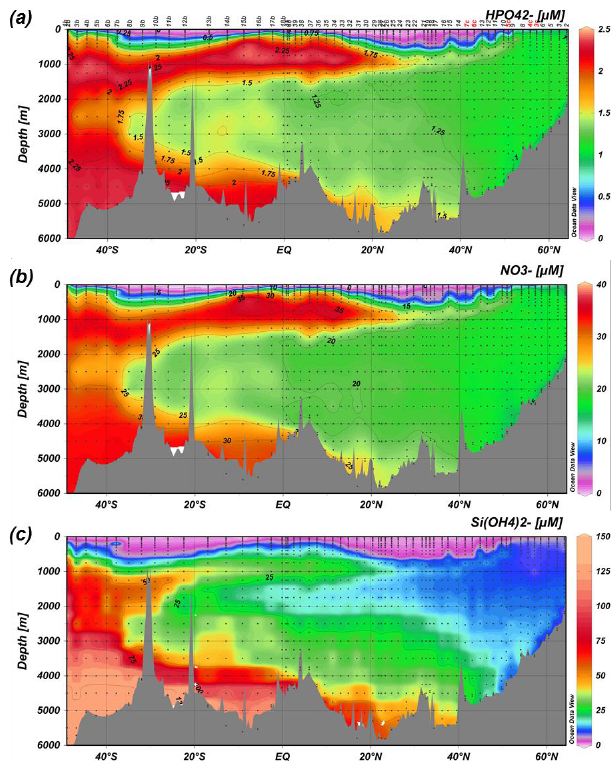
Fig. 3. Interpolated vertical sections of (a) phosphate, (b) nitrate and (c) silicate based on 1440 analysis of water-column samples collected and measured by NIOZ along the Netherlands area of GEOTRACES-A02 section. Stations sampled during leg 4 are la- beled in